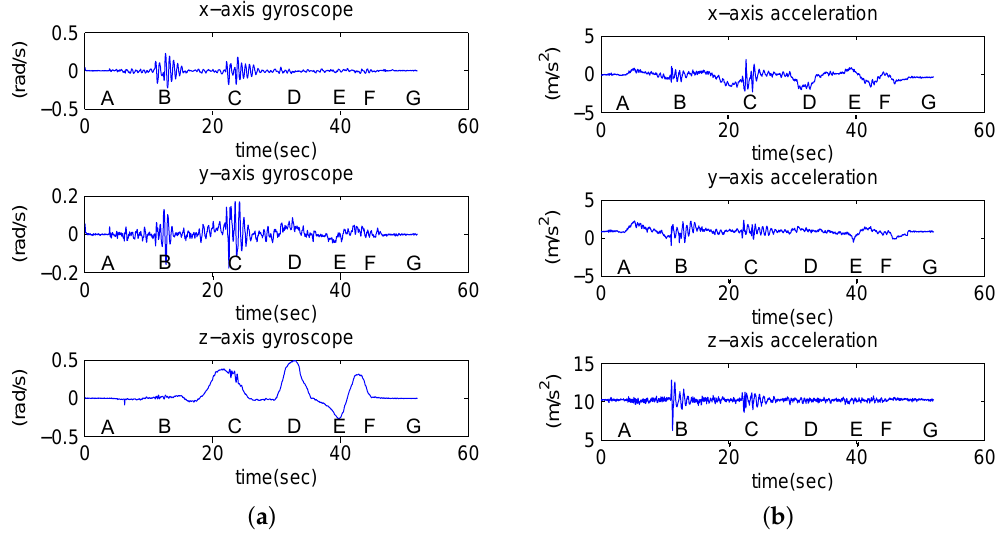
Figure 3. Sensor data recorded during the example drive. ( a ) Gyroscope; ( b )